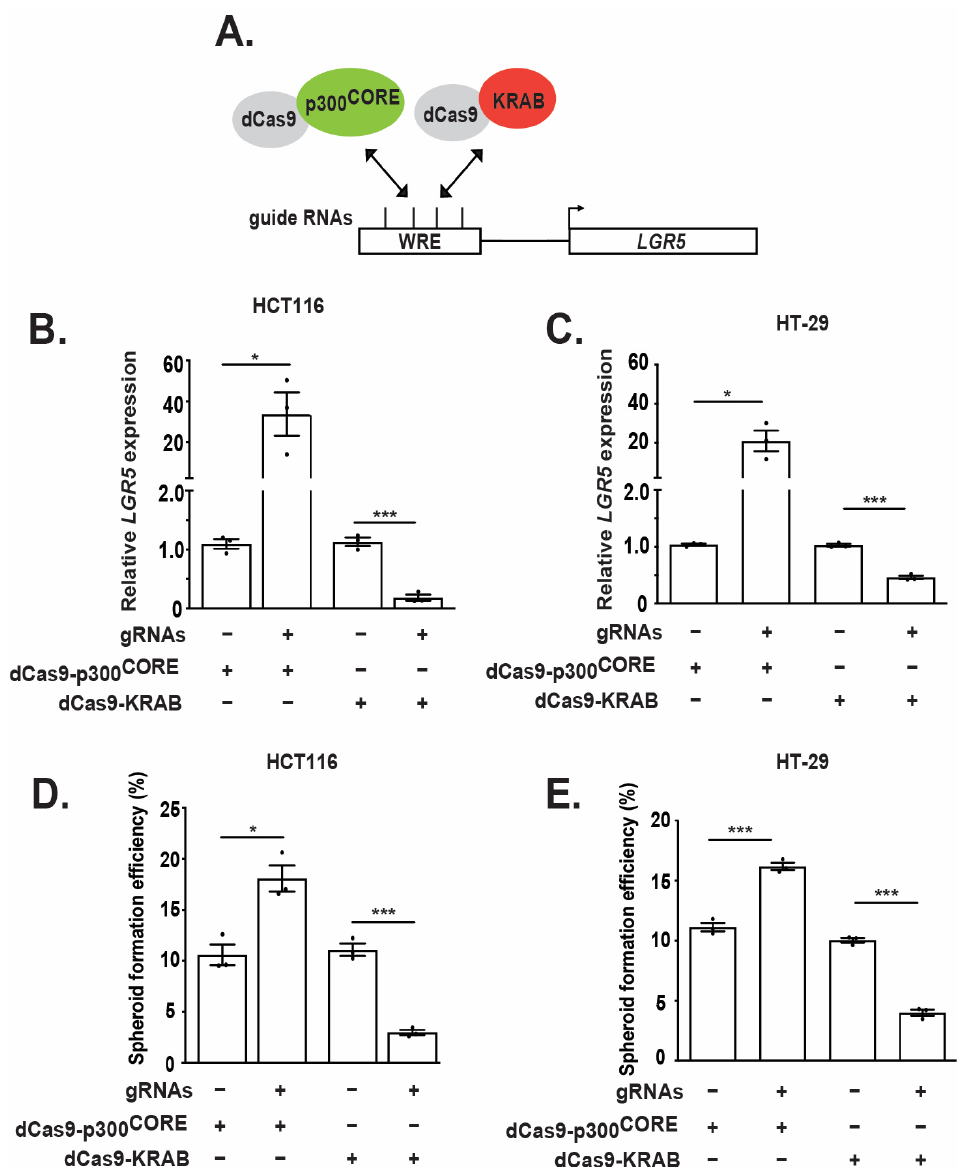
Figure 5. Epigenetic regulation of the WRE impacts LGR5 expression and spheroid formation. ( A ) Diagram of CRISPR activation and interference systems. The relative positions of each guide RNA within the WRE region upstream of the LGR5 locus is denoted with black vertical lines. ( B , C ) RT-qPCR analysis of LGR5 transcripts and ( D , E ) spheroid formation efficiency of HCT116 and HT-29 cells. As indicated, cells were co-transfected with plasmids expressing dCas9-KRAB or dCas9-p300 CORE ± guide RNAs. LGR5 expression values are normalized to ACTB. Data are represented as mean ± SEM (* p < 0.05 , *** p < 0.001).